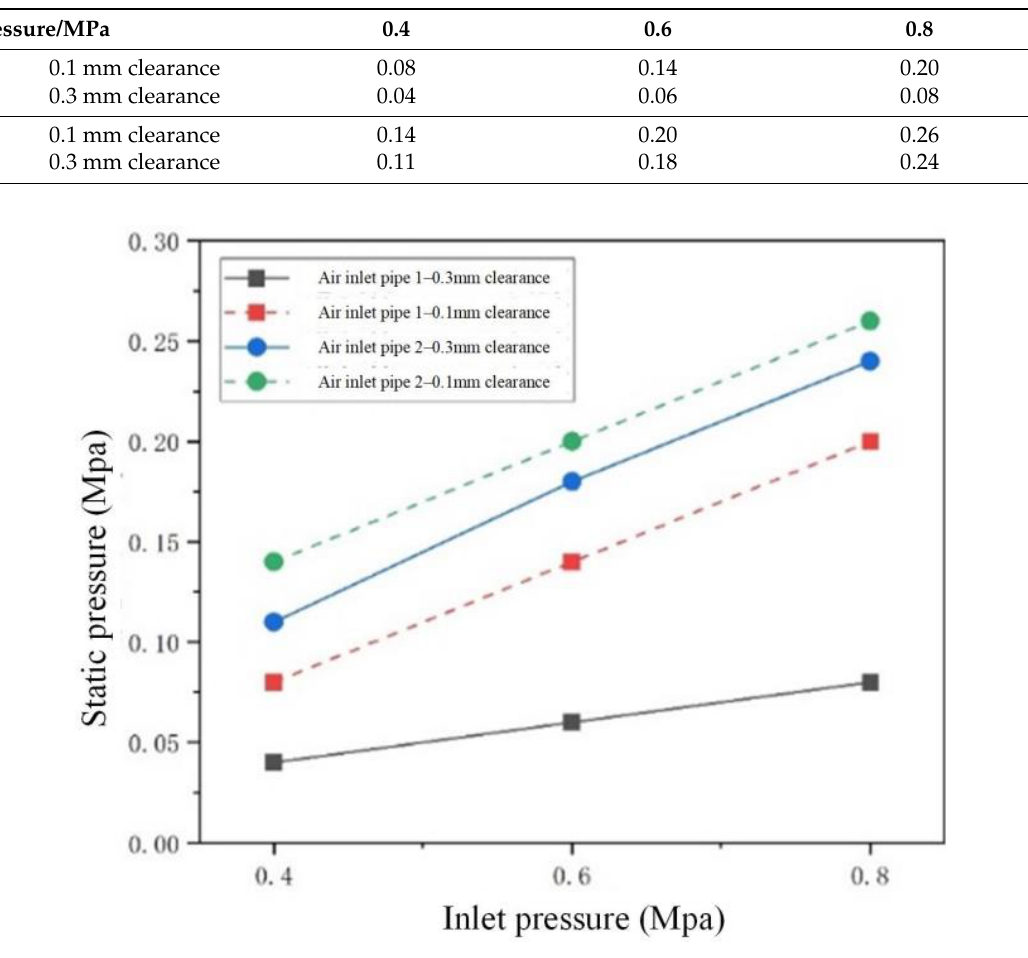
Figure 18. Measured static